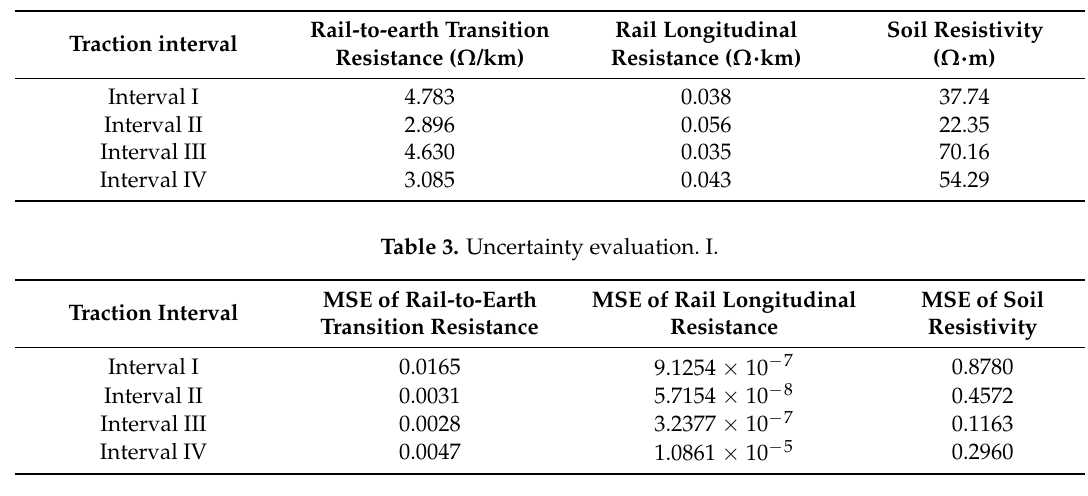
Table 2. Field test results.